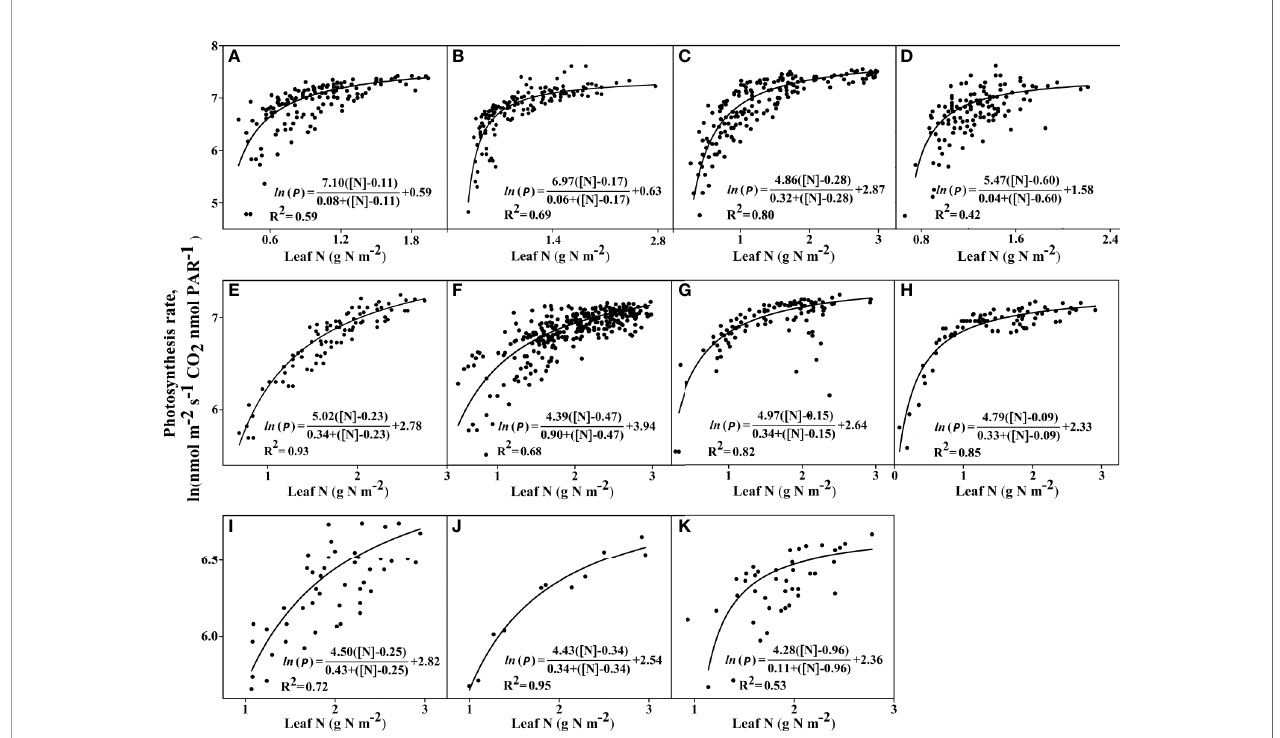
FIGURE 2 | The photosynthetic rates in light-saturated conditions, which are dependent on leaf nitrogen [N] levels. Two C 4 plants: (A) Sorghum bicolor and (B) Zea mays , and nine C 3 plants (C) Triticum aestivum , (D) Oryza sativa , (E) Hordeum vulgare , (F) Glycine max , (G) Helianthus annuus , (H) Solanum tuberosum , (I) Citrus sinensis , (J) Malus domestica , and (K) Prunus persica . All parameters were determined using a best- fi t non-linear regression line, and the R 2 and P -values were determined using one-way ANOVA (Tukey ’ s test). Statistical signi fi cance was de fi ned as P < 0.05. The sources for the data and references presented are given in Dataset_S1 . The complete detailed mentioned in Materials and Methods , Data Sources